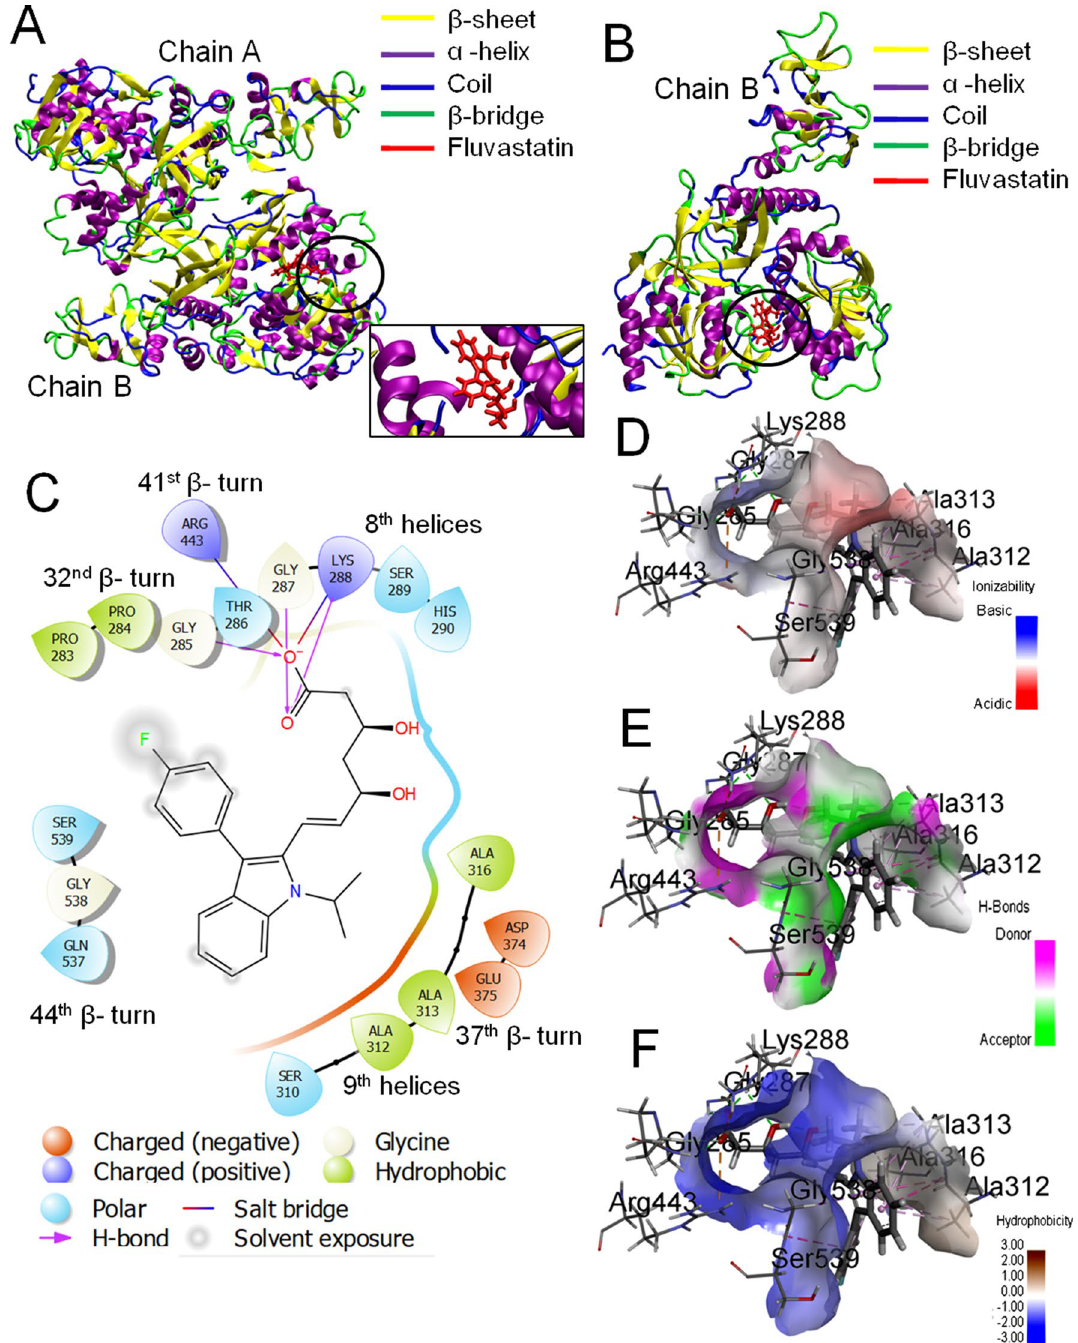
Figure 6. Molecular docking study of fluvastatin to helicase. (A) 3D diagram of ligand–protein complex (chain A and Chain B). (B) 3D diagram of Fluvastatin bound helicase complex (chain B only). (C) 2D diagram for representation of interactions of Fluvastatin with the amino acid residues at the binding site. (D–F) Mapping of binding site cavity according to ionizability, H-bond donor–acceptor residue, and hydrophobicity, respectively, using Discovery Studio Visualizer software, v21.1.0.20298 (https:// disco ver. 3ds. com/ disco very- studio- visua lizer- downl oad). All 3D images were generated using the VMD (Visual Molecular Dynamics) software (version 1.9.3) and 2D images were generated by the graphical user interface Maestro, Schrödinger (https:// www. schro dinger. com/ produ cts/ maest